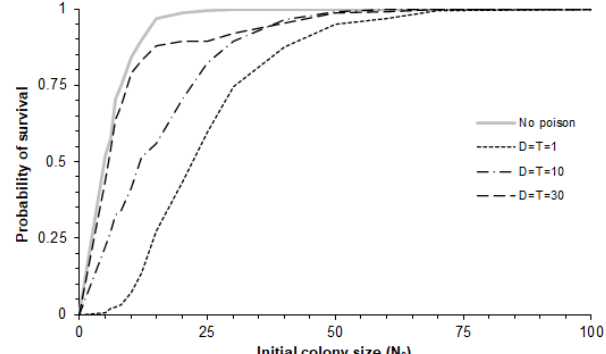
Figure 3. Model predictions for the probability of survival as a function of different restocking (initial) population sizes and dif- ferent impacts of catastrophes. In each case involving poisoning, the cumulative loss rate due to poison is one individual per year. Thus, for the three curves for which the numbers of individuals poi- soned in each catastrophe ( D ) were 1, 10 and 30, the correspond- ing frequencies of poisoning events ( T ) were once every 1, 10 and 30 years, respectively, with 95% intervals (0.0253 T , 3.69 T ) in each case. The initial population sizes used were 0, 5, 6, 7, 8, 10, 12, 15, 20, 25, 30, 40, 50, 60, 70 and